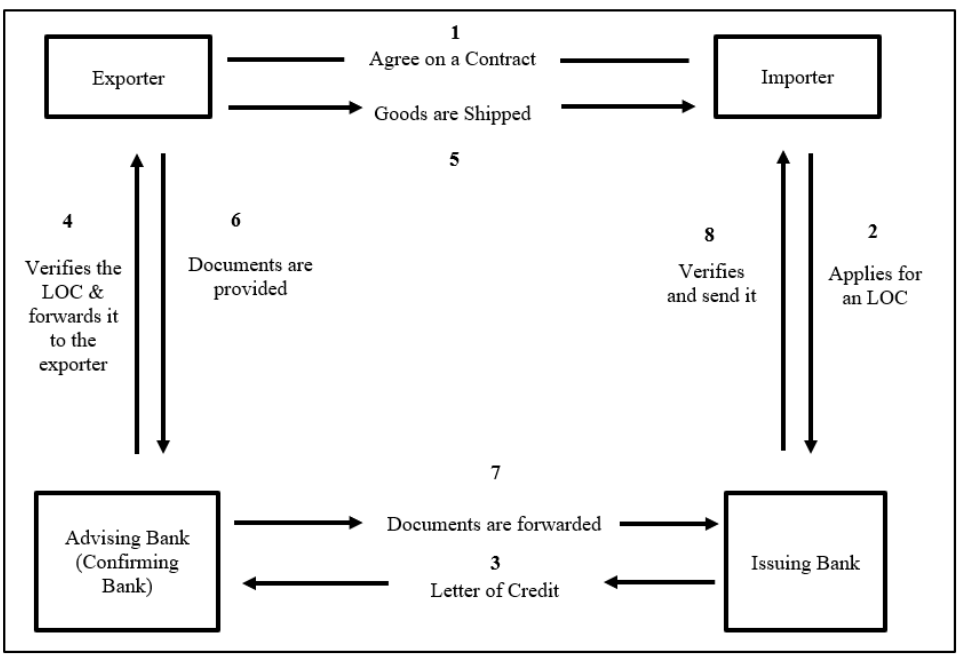
Figure 1. A process flow of the operation of LC Conventional. Source: Drip Capital https://www.dripcapital.com/resources/blog/letter-of-credit-lc (accessed on 4 January 2020).